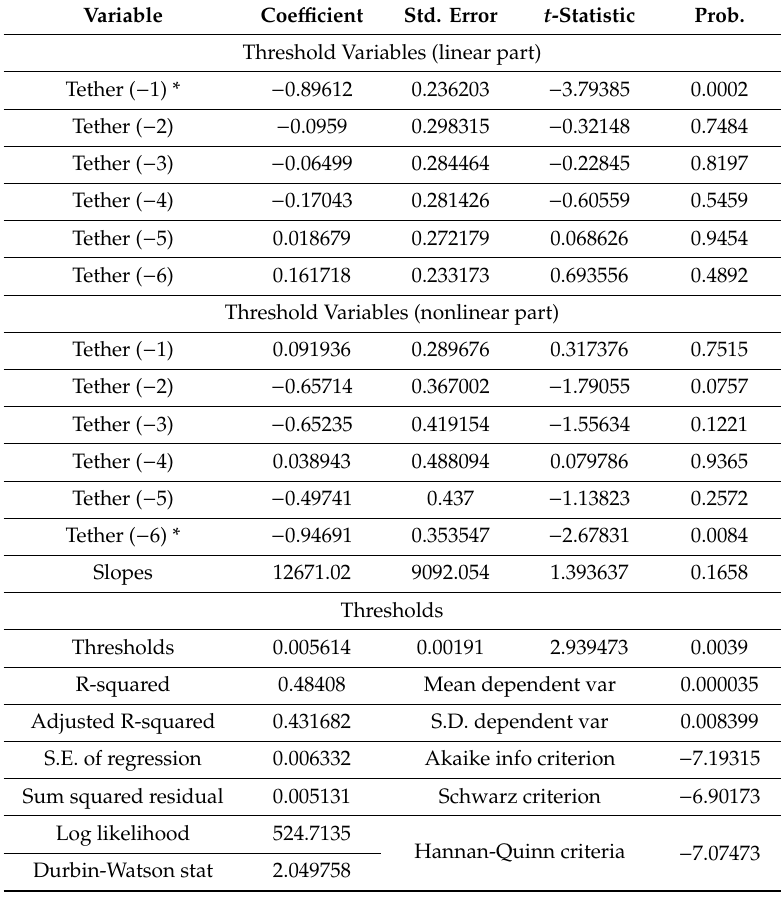
Table 6. Linearity test estimates.